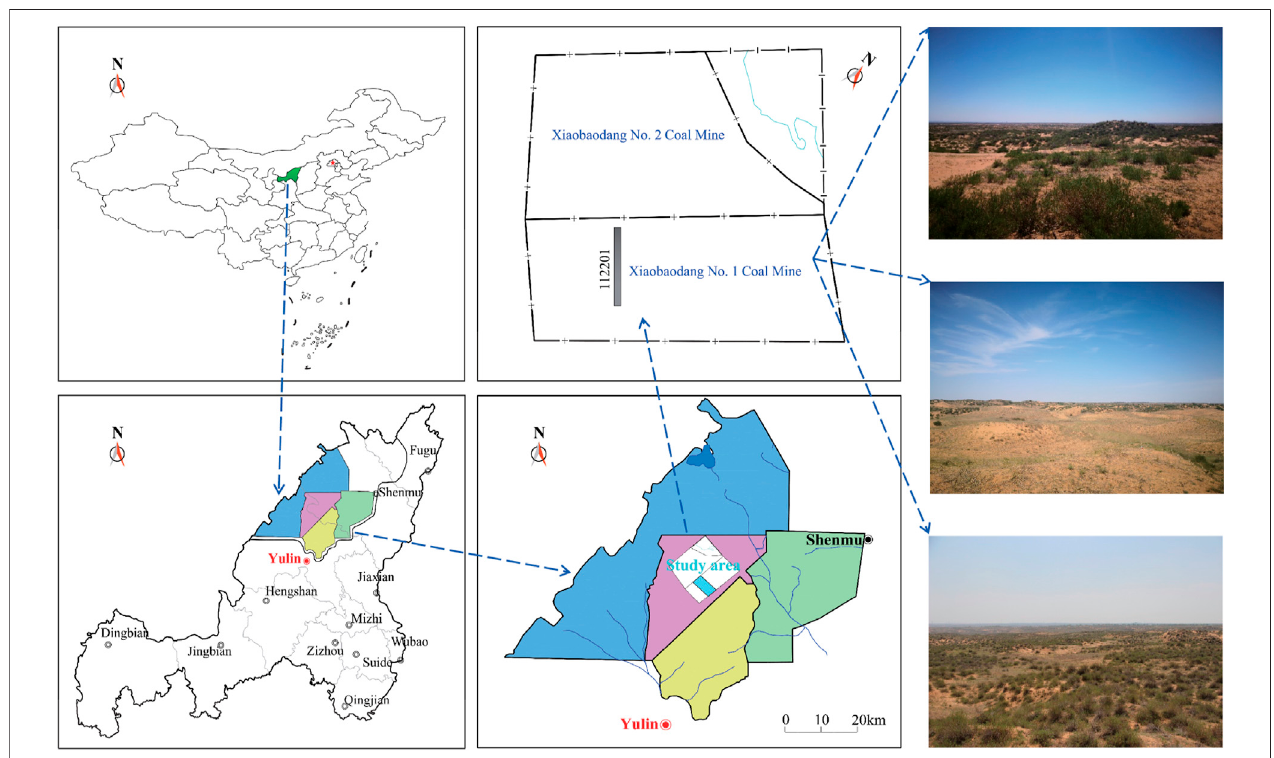
FIGURE 2 | Location of the study